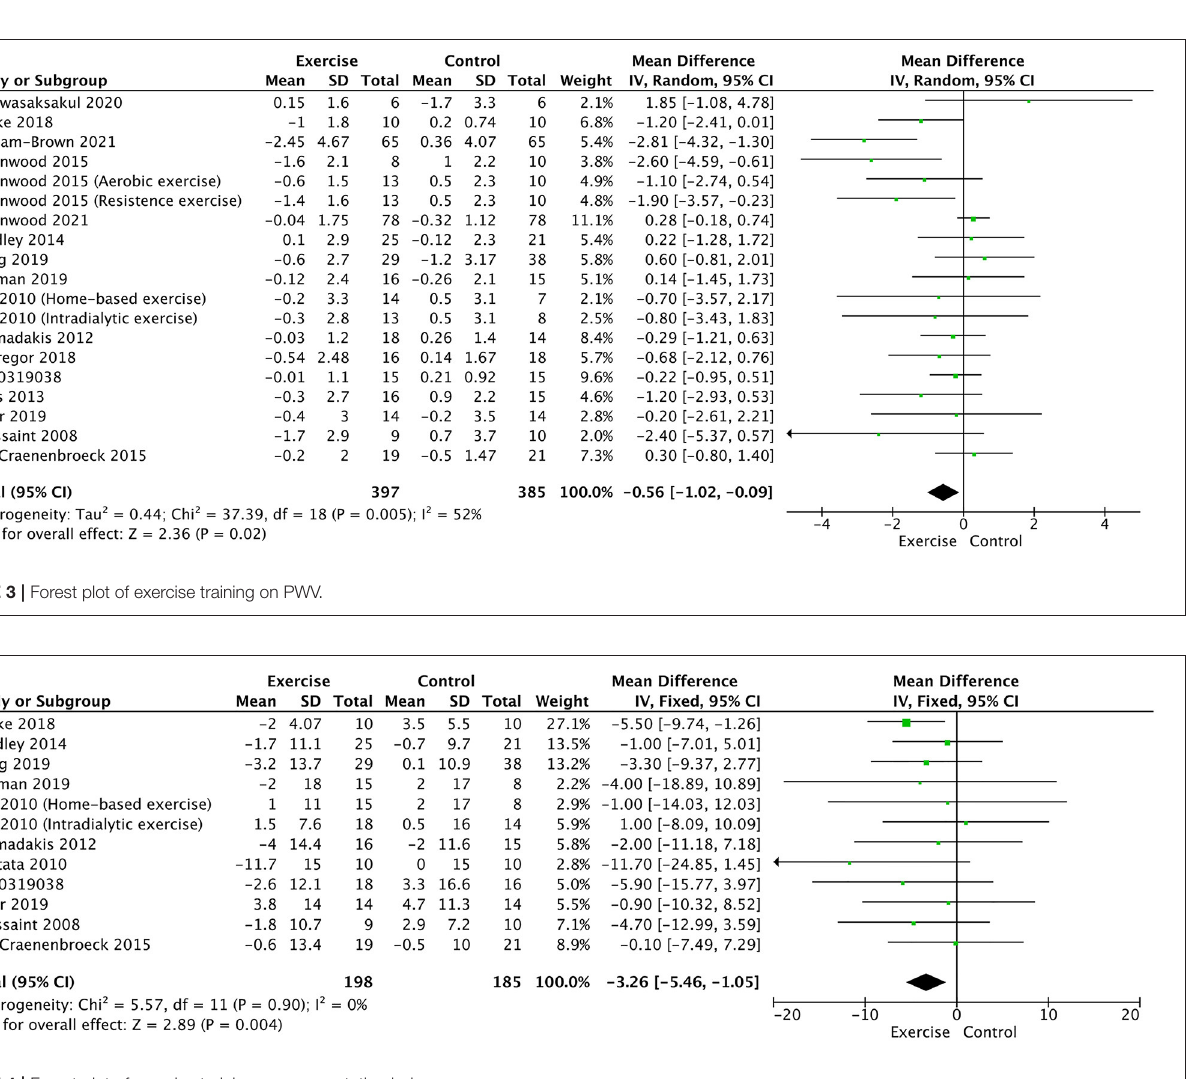
FIGURE 4 | Forest plot of exercise training on augmentation